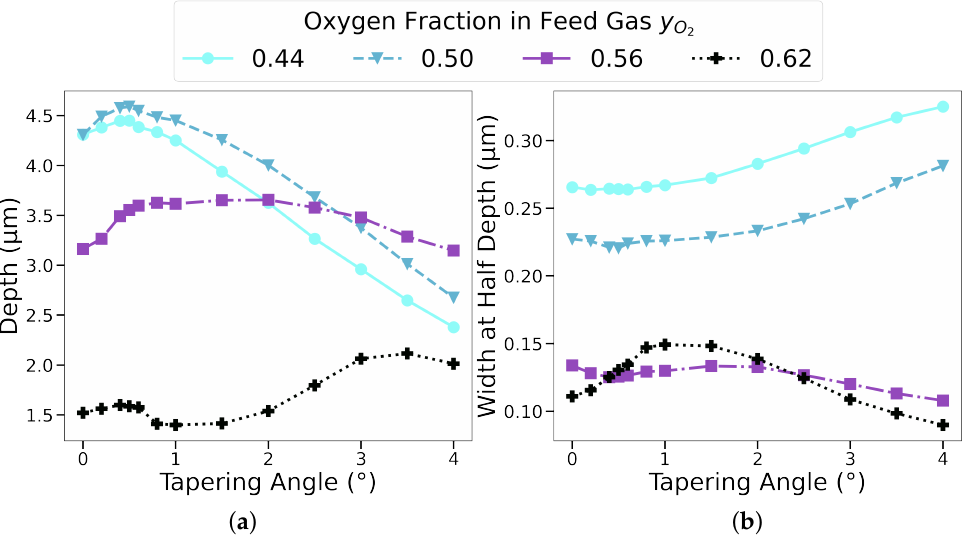
Figure 8. ( a ) Depth and ( b ) width at half-depth (WAHD) of a cylindrical hole as the mask tapering angle was varied from 0° to 4°. The depth is maximized when the WAHD reaches its minimum for all the gas compositions. For lower-oxygen-content settings, where the passivation does not attenuate the changes in tapering, the depth peaks after an initial angle increase and decreases significantly as the angle increases further, while the WAHD reaches a minimum after an initial angle increase and increases significantly with a further angle increase. Since the most significant changes were expected for small taper angles, we used more sample points in the range from 0° to